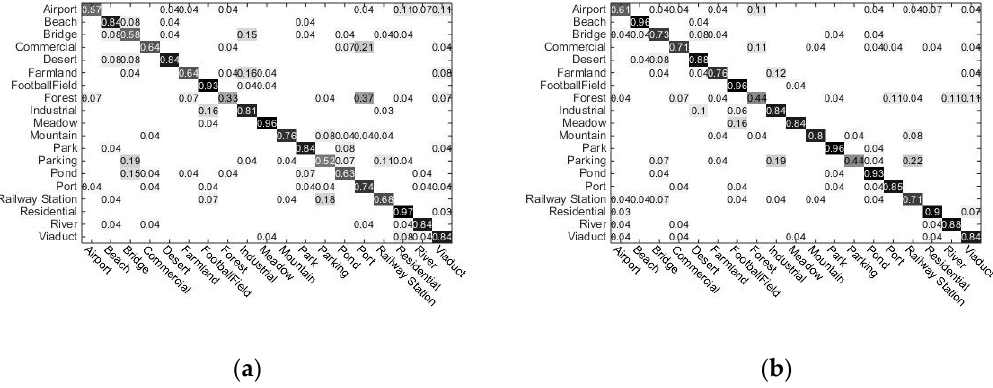
Figure 6. Confusion matrices based on SIFT; ( a ) Traditional LLC (SIFT); ( b ) Proposed method (SIFT).